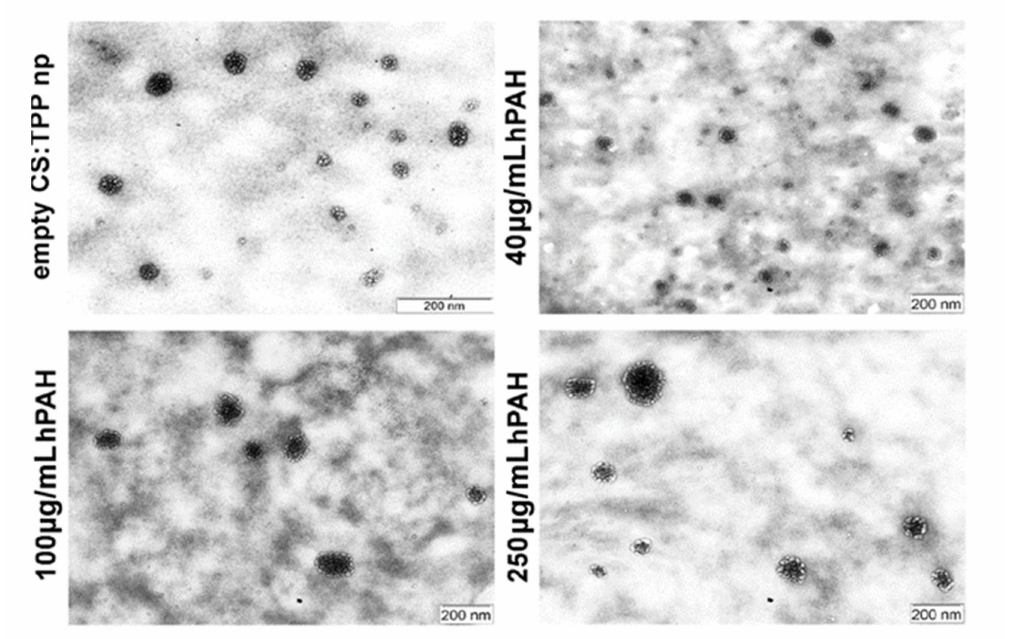
Figure 6. Transmission electron microscopy (TEM) analysis of optimized nanoparticles (5:1; CS:TPP weight ratio) with different hPAH loading. For further details see Materials and